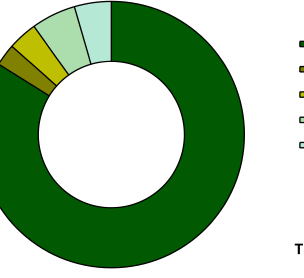
Figure 9. Emissions distribution in prefabrication stage of B1 building.